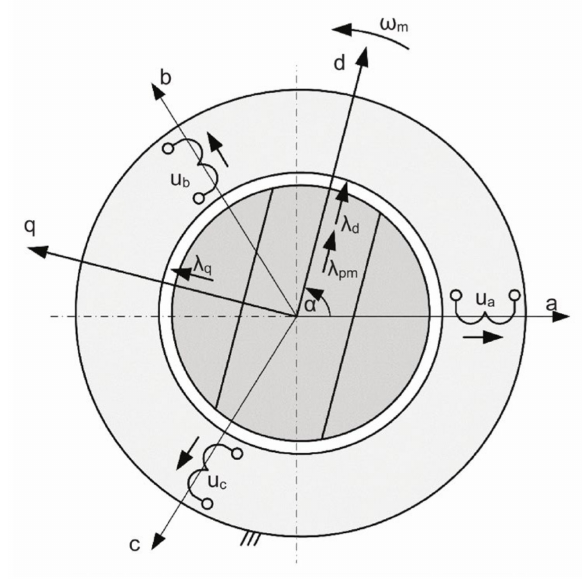
Figure 4. PMSM in a, b, c, and d–q